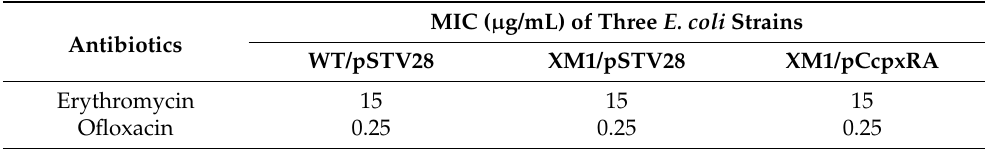
Table 3. Susceptibility of Escherichia coli strains to various antibiotics.